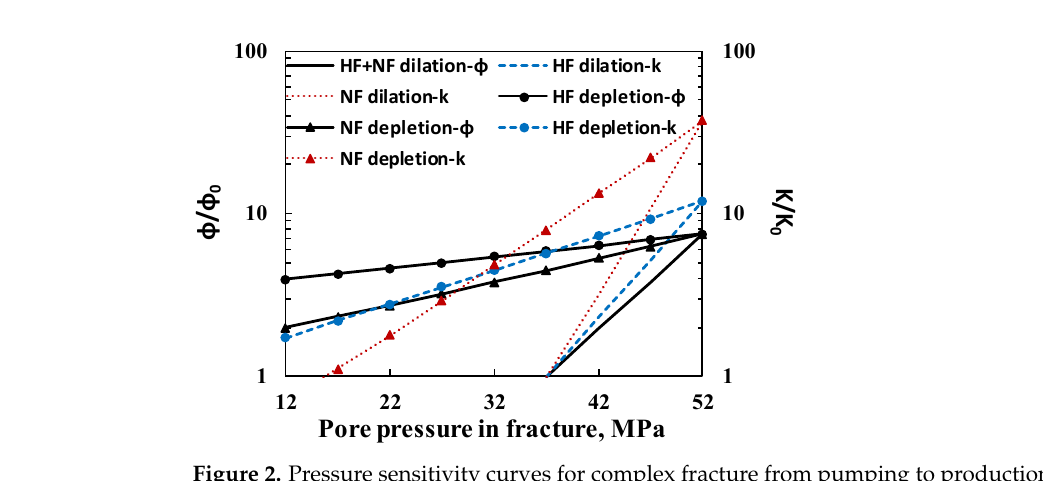
Figure 2. Pressure sensitivity curves for complex fracture from pumping to production period.